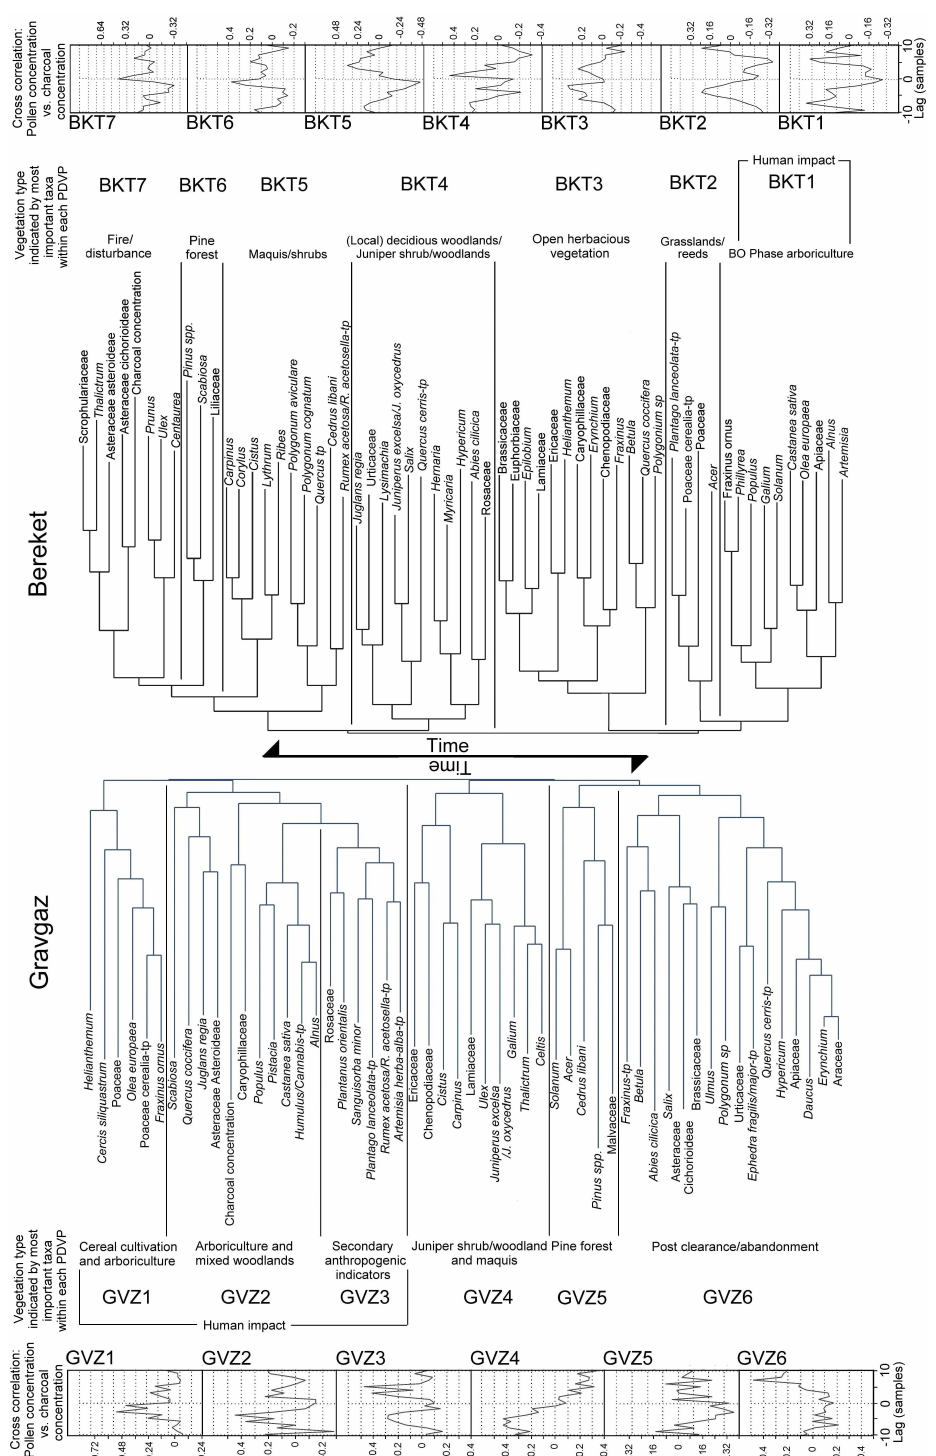
Fig. 5. Neighbour Joining tree diagrams for charcoal and pollen concentration data in the Bereket basin (top) and Gravgaz Marsh (bot- tom). Vegetation types associated with the most important pollen taxa in each PDVP are based on van Zeist et al. (1975), Bottema and Woldring (1990) Fontaine et al. (2007) and Kaniewski (2007a). Arrows indicate the order in which each PDVP reaches its maximum domi- nance in the pollen spectrum. On the far ends of the figure are Cross Correlograms displaying the correlation between each PDVP and relative charcoal